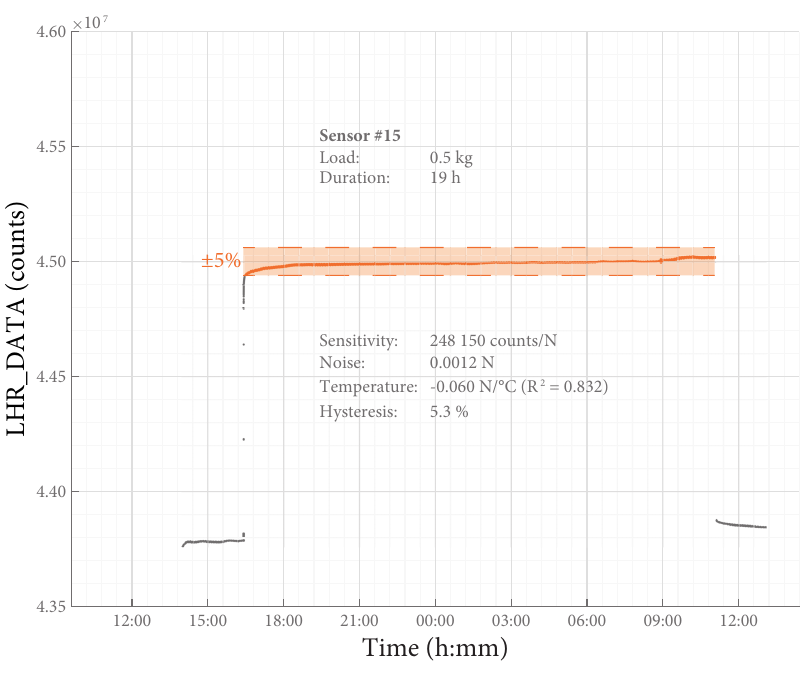
Figure 6. Static load test. The results of a typical static load test. The typical sensitivity (Table 2) can be used to convert LHR_DATA to a measure for force: 1500 counts approximate 0.01 N.